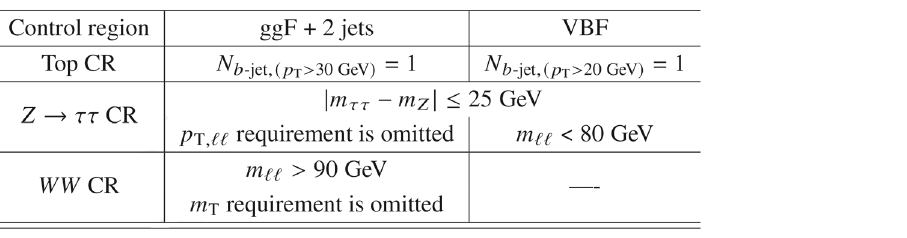
Table 4 Event selection criteria